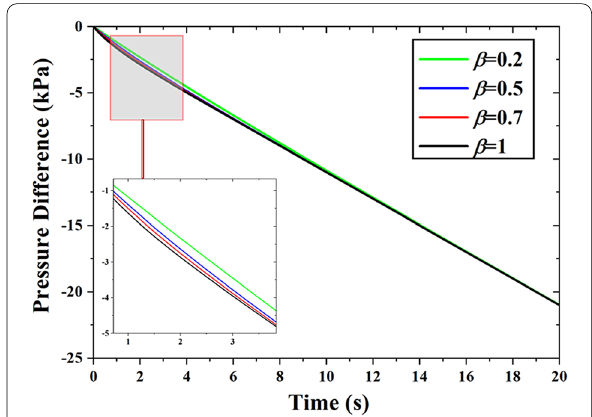
Figure 3 Relationship of β and pressure difference with